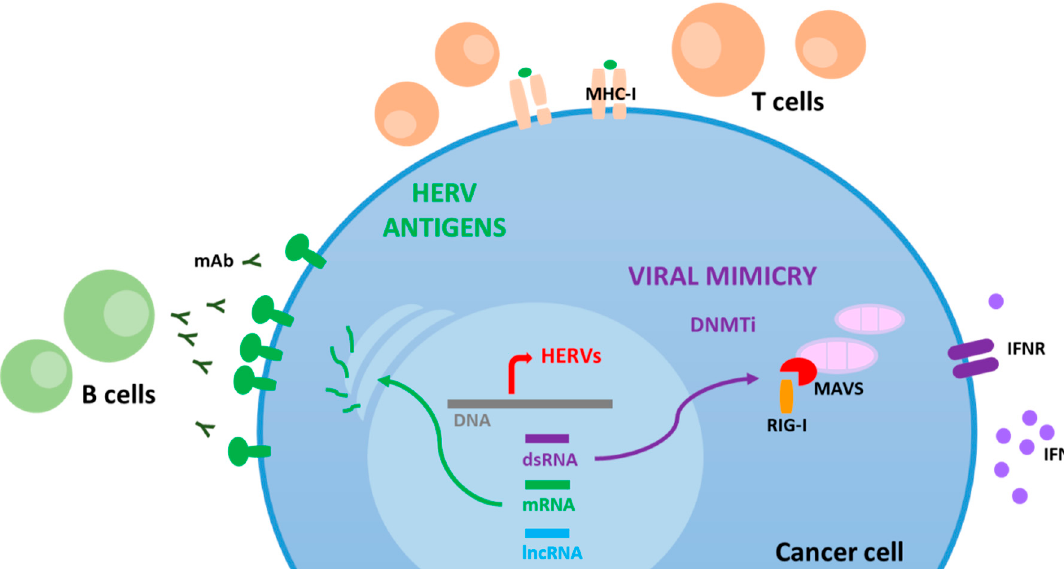
Figure 1. HERV reactivation in cancer cells may result in a viral mimicry state, generation of highly tumor-specific antigens and expression of LTR-activated transcripts, including long noncoding RNAs (lncRNAs).